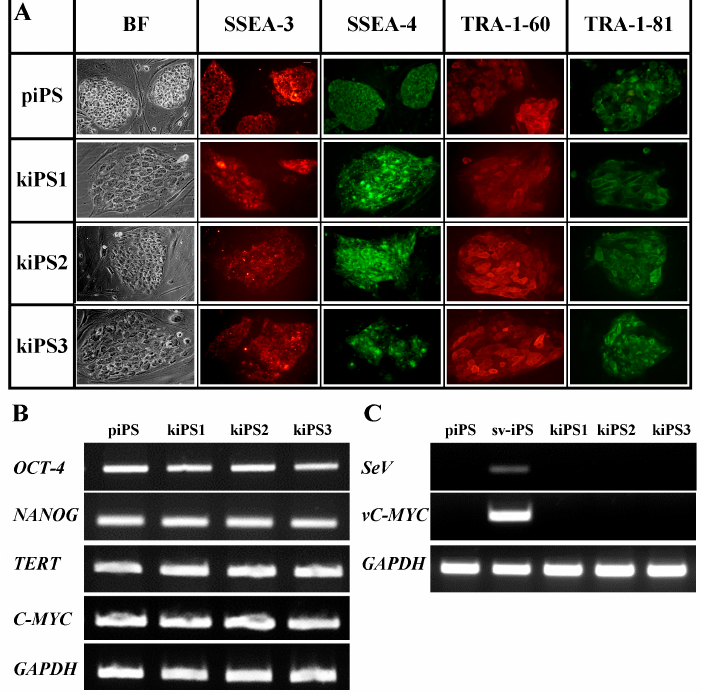
Figure 2. Acquired keratinocytes-derived-iPS (kiPS) cell lines express endogenous pluripotency markers and silence viral transgenes: ( A ) kiPS cell lines expressed surface antigens, i.e., SSEA-3,